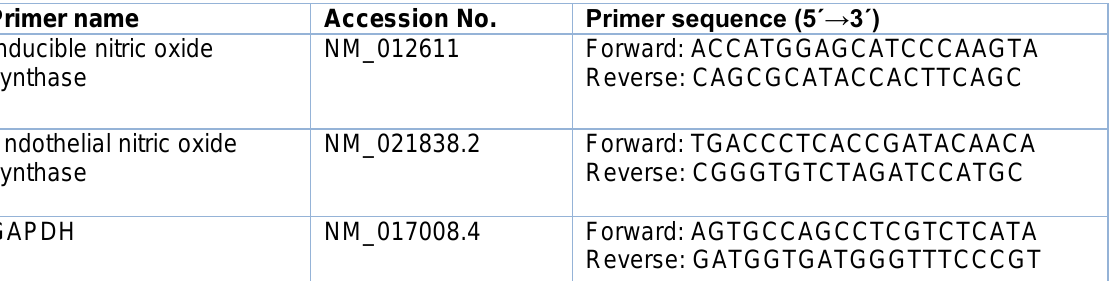
Table 1: Primer sequences used for real-time